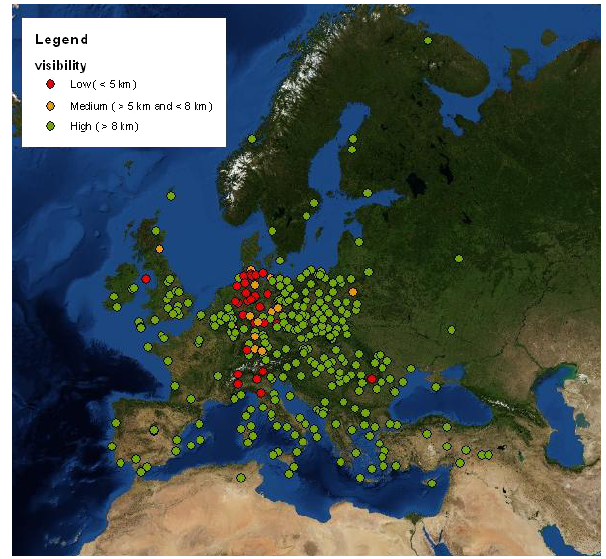
Figure 3. Visibility conditions (km) occurring 05 September 2011,